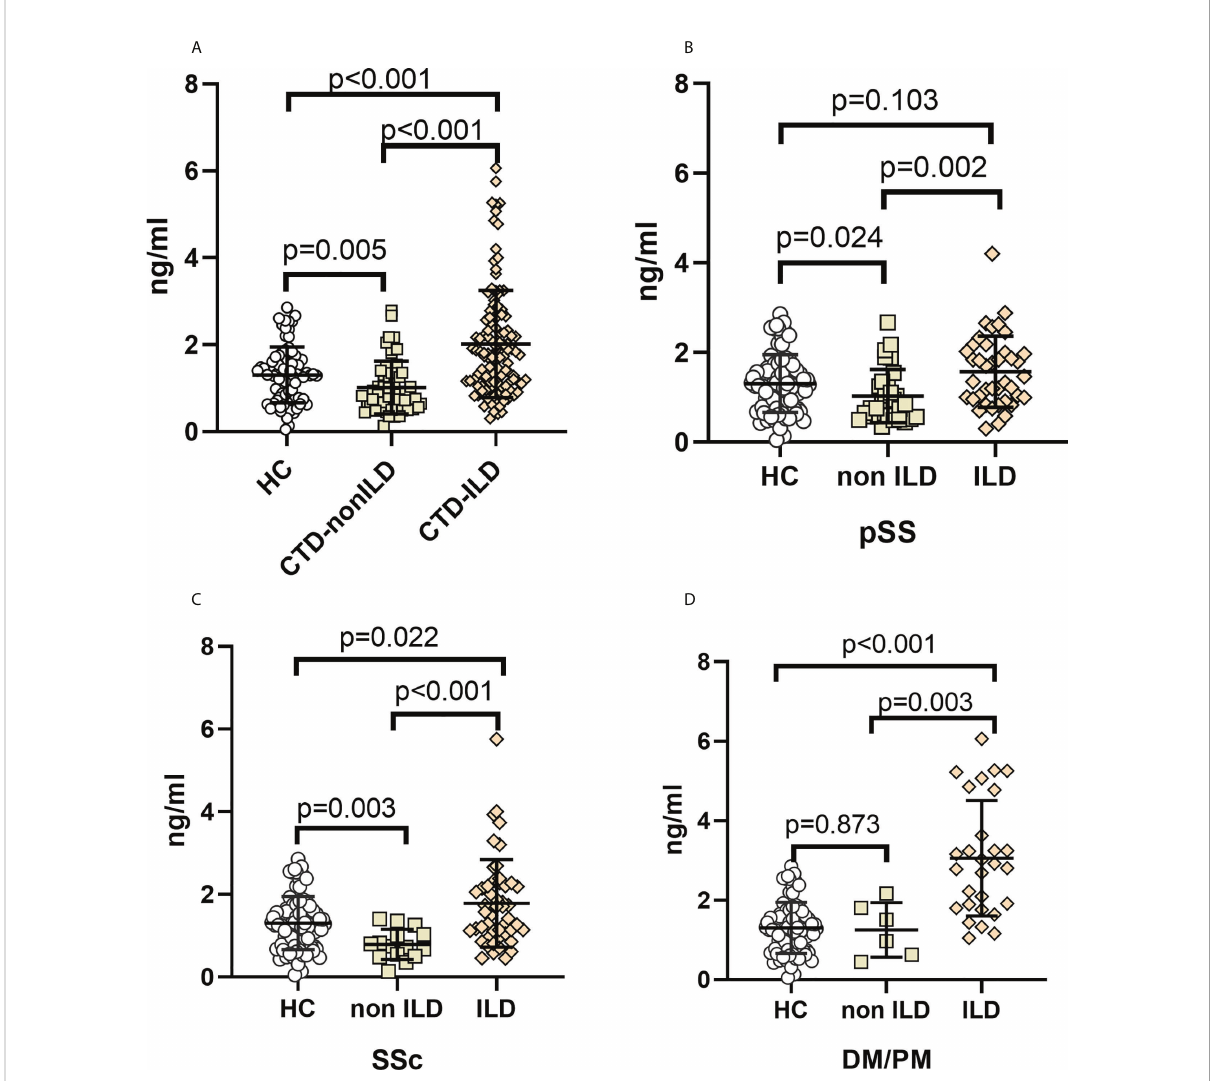
FIGURE 1 Elevation of MUC5AC levels in CTD-ILDs (A). CTD-ILD, CTD-non ILD, and healthy controls. (B) . pSS-ILD, pSS-non ILD, and healthy controls. (C). SSc-ILD, SSc-non ILD, and healthy controls. (D) . DM/PM-ILD, DM/PM-non ILD, and healthy controls. Dot plots depict levels (measured by standard solid-phase enzyme-linked immunosorbent assay) of MUC5AC in individual serum samples from patients without ILD (interstitial lung abnormality ILD score 0), patients with ILD (indeterminate ILD (ILD score 1), mild ILD (ILD score 2), and advanced ILD (ILD score 3)) and healthy controls, Each symbol represents an individual patient; horizontal lines show the mean. p values were determined by Mann-Whitney U